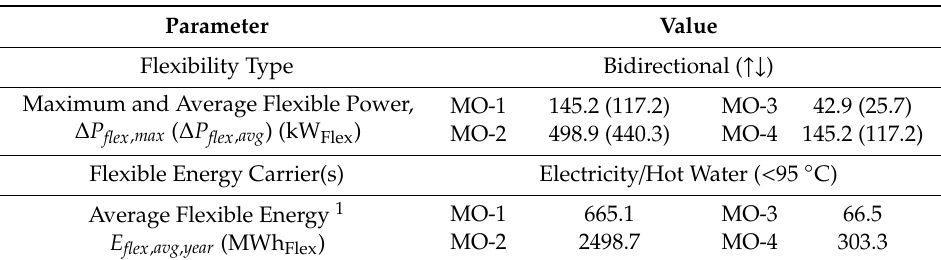
Table 9. Performance Dimension of the identified EFM.